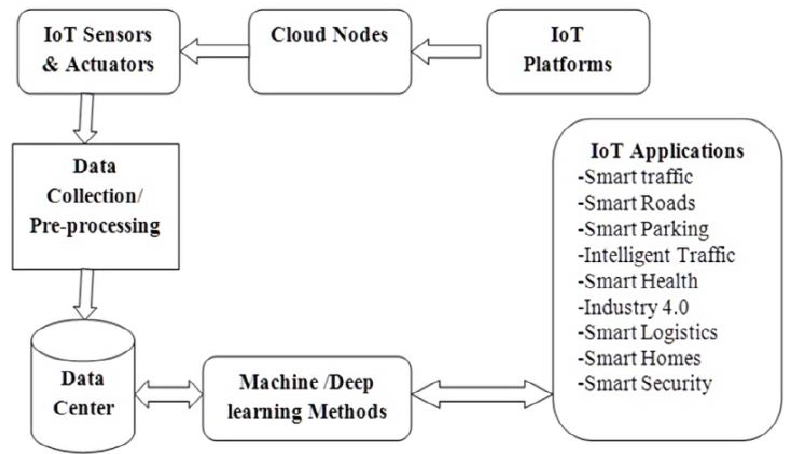
Figure 2. IoT application in ITM.